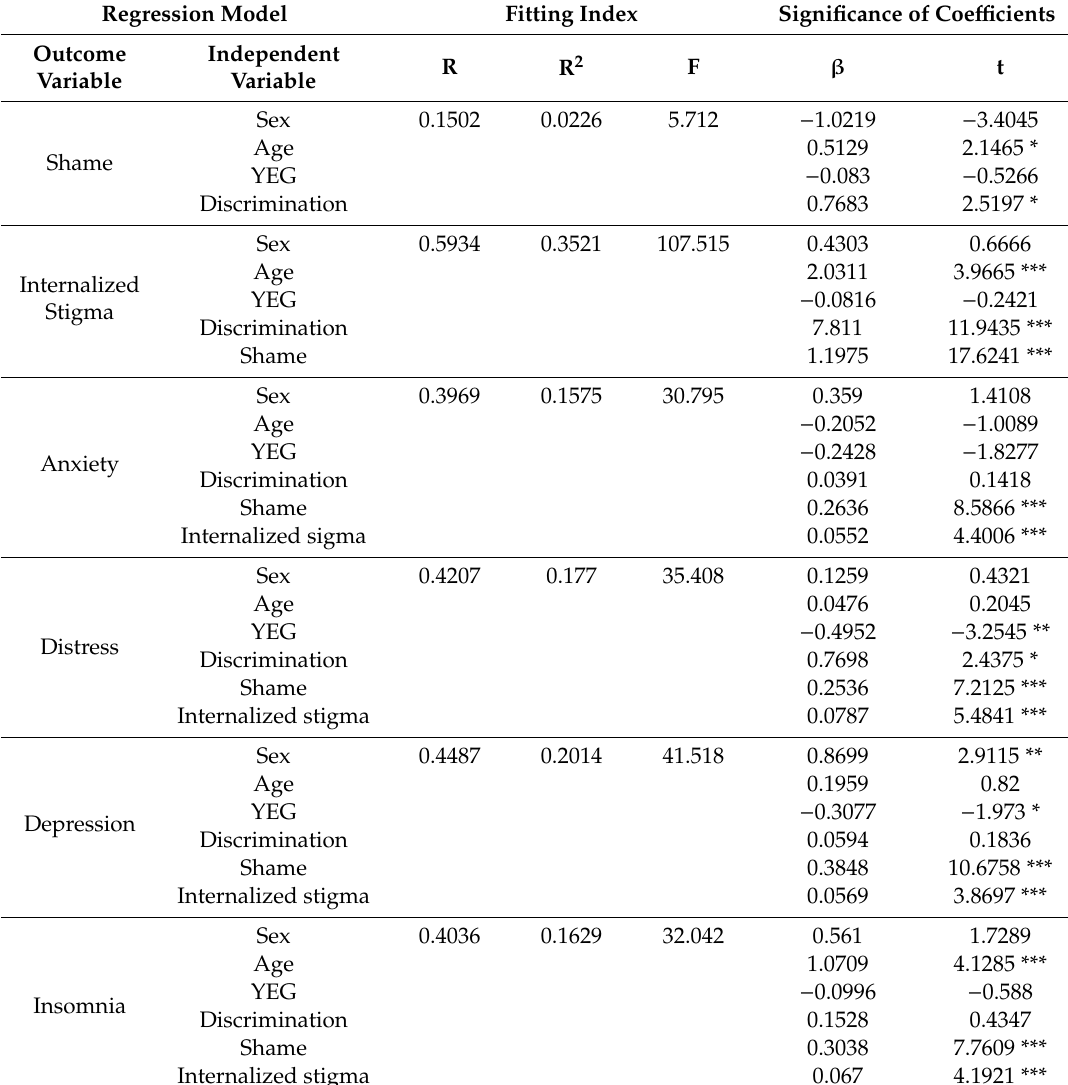
Table 3. Regression